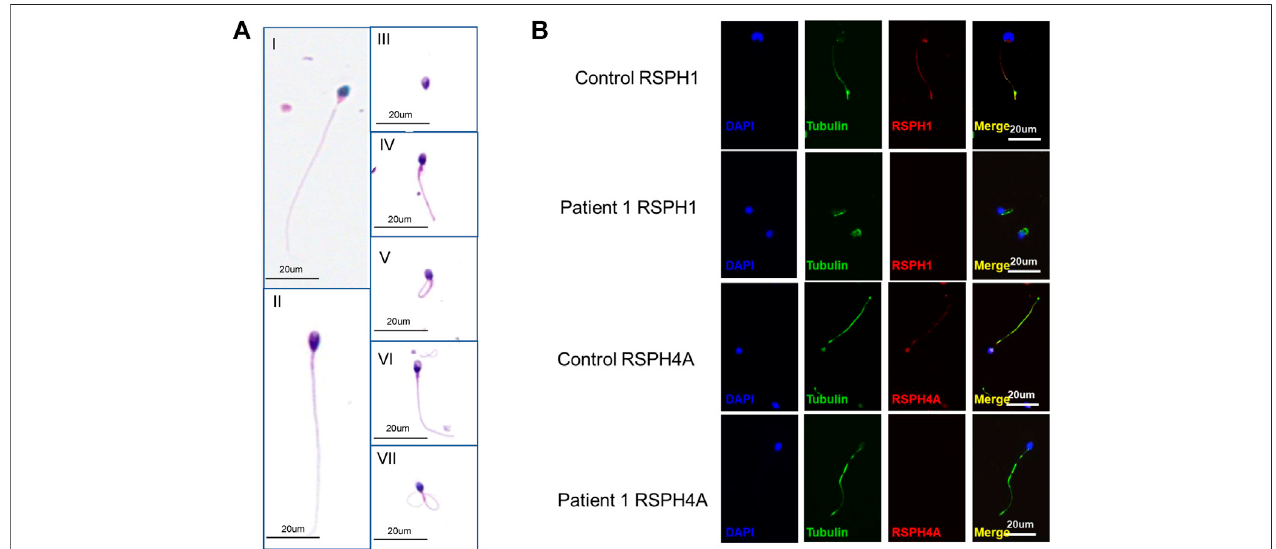
FIGURE 3 | Phenotypic features of the RSPH4A mutant sperm and RSPH4A immunostaining in human spermatozoa. (A) Papanicolaou staining of spermatozoa frompatient1andahealthycontrol. (A -I ) Normalmorphologyofspermatozoafromahealthycontrolmale. (A -II ) Observednormallengthofthespermfrompatient1with RSPH4A variants. Inaddition, multiple malformationscanbe observed, including (A -III ) absent, (A -IV ) short, (A -V ) coiled, (A -VI ) bent, and (A -VII ) irregularcaliber fl agella. (B) RSPH4A and RSPH1 are expressed in the whole length of the sperm fl agella in the normal control but absent in patient 1.